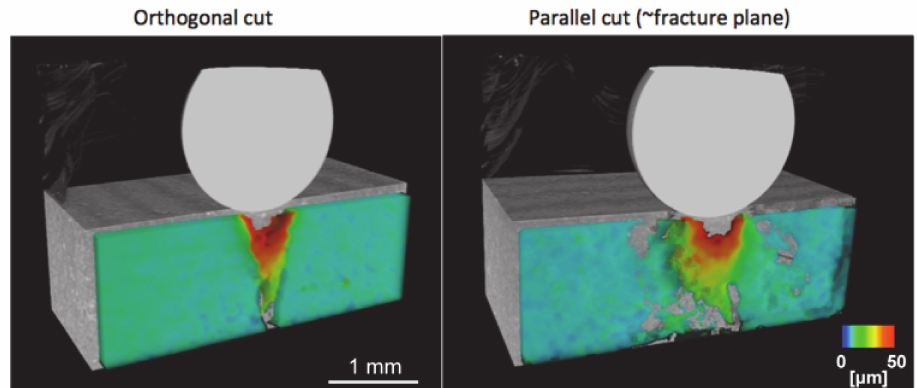
Figure 12. A Si-Nitride sphere is used to indent an oil shale sample (bedding is vertical) to observe the response of the sample. Two orthogonal views are shown. The Z (i.e., vertical) displacement field obtained via DVC has been overlaid in color. The strongly anisotropic damage zone following the sample fabric is evident. The DVC volumes were calculated after the first fracturing event (parallel to the bedding) during the loading of the sample.